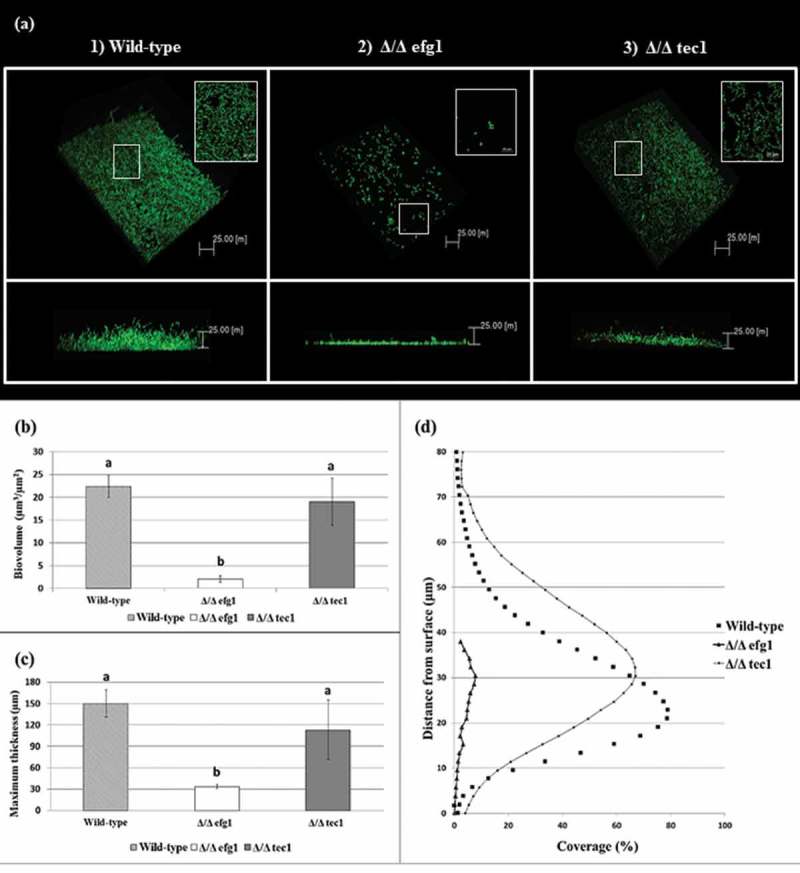

Candida albicans biofilm structures and corresponding quantitative data from confocal scanning laser microscopy assays. (a) Representative three-dimensional and orthogonal images of the structural organization of the 48 h biofilms of C. albicans wild-type (WT) (1) and mutant strains: Δ/Δ efg1 (2) and Δ/Δ tec1 (3) (green color denotes labeling with SYTO9 for live yeast cells). Mean and SD of biovolume (b) and average biofilm thickness (c) of C. albicans WT and mutant strains (Δ/Δ efg1 and Δ/Δ tec1) determined by COMSTAT2 analysis. The average biovolume and biofilm thickness were calculated from five independent samples from each strain. Values followed by the same letter are not significantly different (p > 0.05), as determined by an analysis of variance for all pairs using Tukey’s test. The profile of the distribution of C. albicans WT and mutant strains (Δ/Δ efg1 and Δ/Δ tec1) in the biofilms is represented in (d).